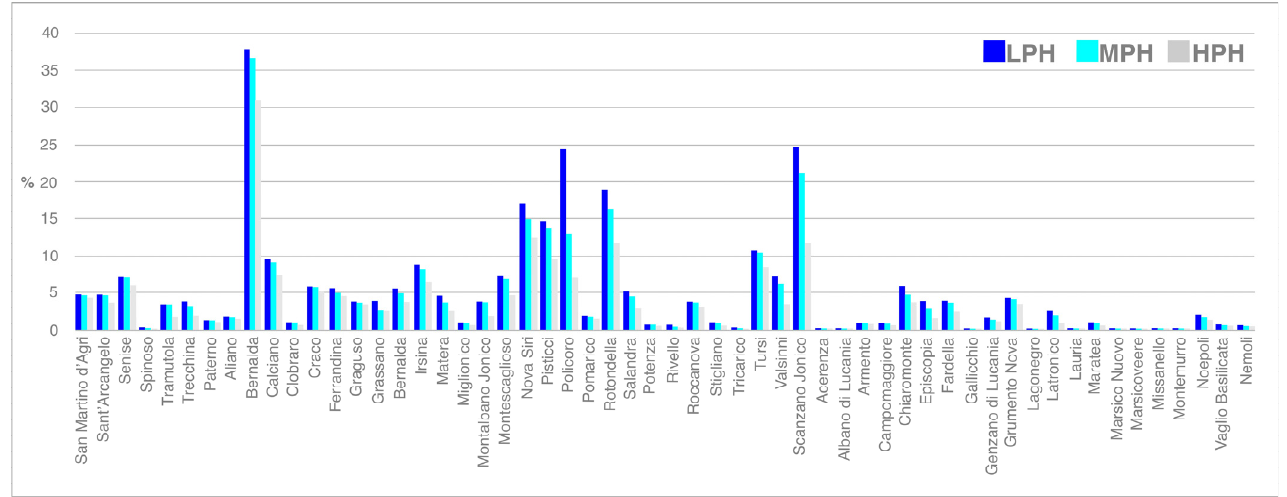
Figure 4. Percentage of the municipal territory affected by floodable areas for LPH, MPH, and HPH.